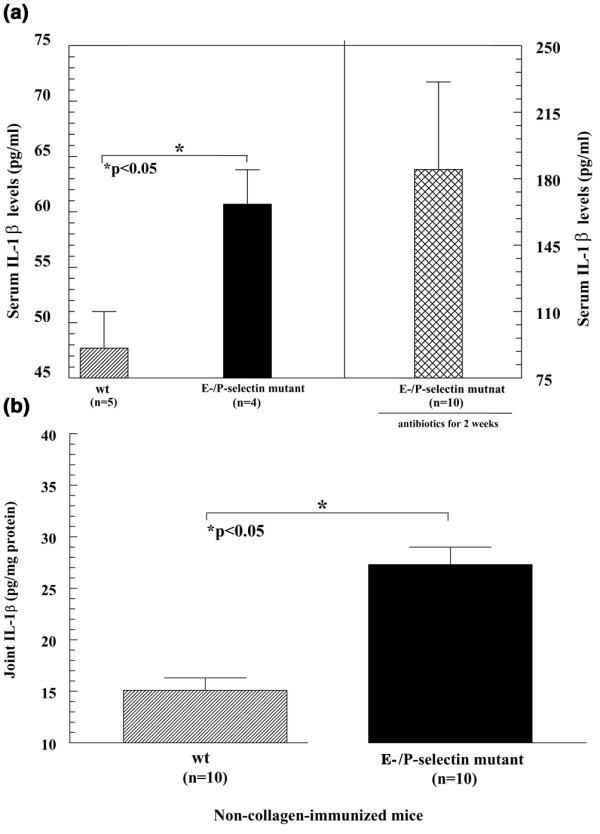
IL-1β expression in serum and joint tissue from non-collagen-immunized mice. (a) IL-1β was significantly elevated in serum from nonimmunized E/P-selectin mutant compared with nonimmunized wild-type mice. Serum from E/P-selectin mutant mice kept on antibiotics for 2 weeks also had elevated serum IL-1β levels, indicating that the basal overexpression of IL-1β in nonimmunized E/P-selectin mutant mice is not due to bacterial infections. (b) IL-1β was also significantly increased in joint homogenates from nonimmunized E/P-selectin mutant compared with nonimmunized wild-type mice. Values are expressed as mean ± standard error of the mean. *P < 0.05. n, number of mice (panel (a) or number of joints (or mice for serum; panel (b); wt, wild-type.